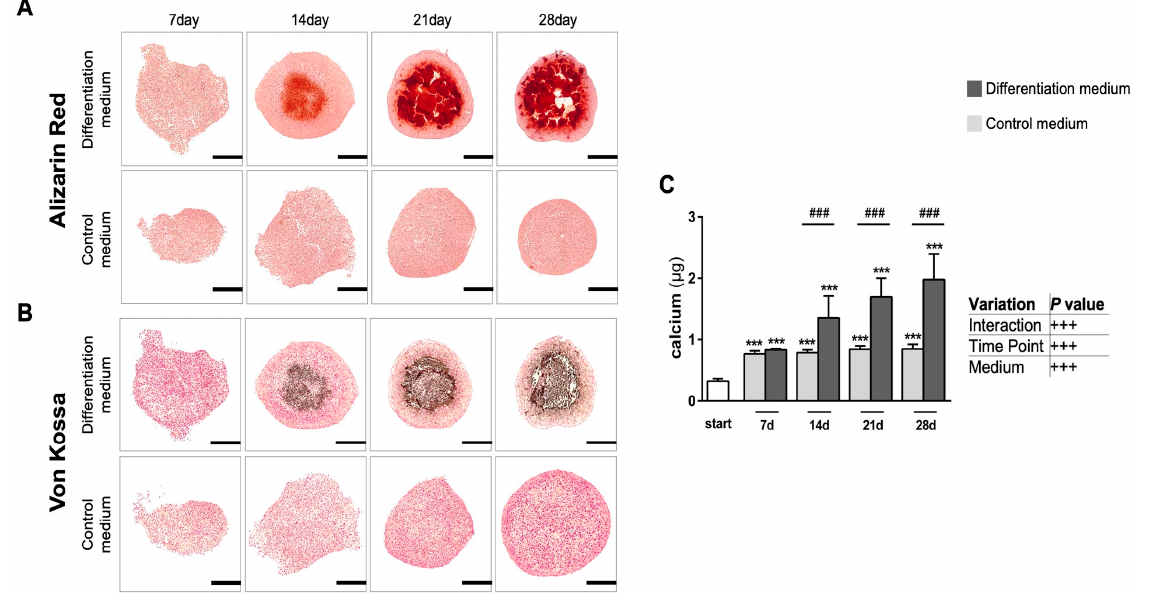
Figure 3. Qualitative and quantitative evaluation of calcium deposition within spheroids. ( A ) Alizarin Red staining over a culture period of up to 28 days. Note that Alizarin sulfonic acid stains calcium deposits deep brick orange-red. ( B ) Corresponding von Kossa staining, showing calcifications in greyish-black. Note that calcium deposition is not observed in non-differentiating controls. Representative images from sectioning three randomly selected spheroids ( n = 3) per condition. Scale bars are 200 µm. ( C ) Spectrophotometric quantification of the extracted precipitated calcium at 405 nm. Significant differences were evaluated using a two-way ANOVA of the Johnson transformed data ( n = 6, mineralizing groups; n = 5, control groups), followed by Tukey’s post hoc test. ### p < 0.001 as indicated; *** p < 0.001 vs. starting day. Data represent geometric mean ± 95% CI.